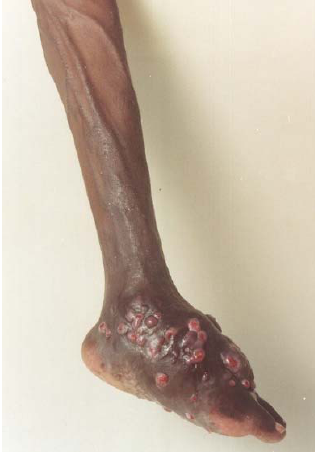
Figure 7. Massive mycetoma foot with dilated tortuous veins at and proximal to the mycetoma site. Unusually and for unknown reasons, the tendons and the nerves are spared until very late in the disease process; this may explain the rarity of neurological and trophic changes even in patients with long-standing mycetomas. The absence of trophic changes may be explained by the more than adequate blood supply in the mycetoma-infected area [34].